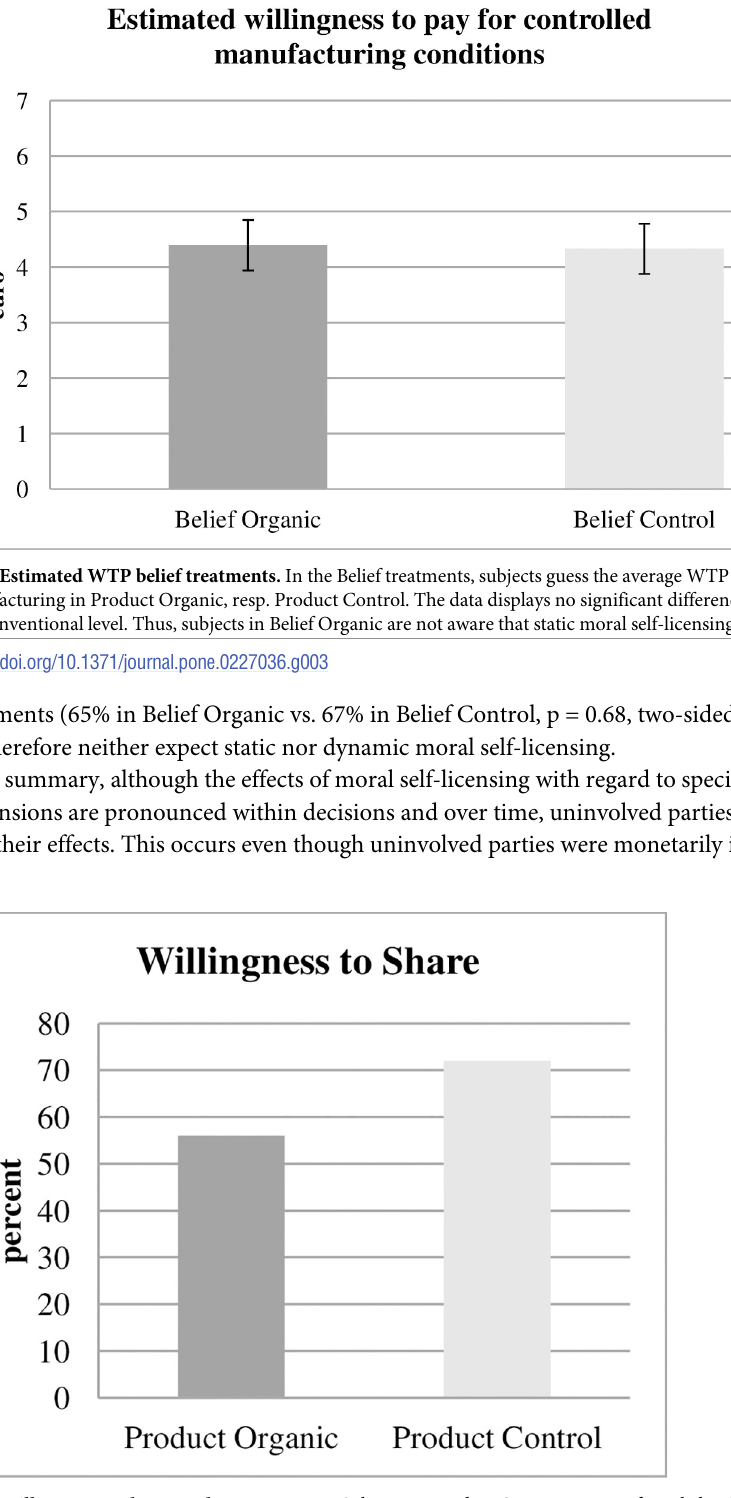
Fig 4. Willingness to share product treatments. Subjects in Product Organic are significantly less likely to share their show-up fee of euro with local refugees than subjects in Product